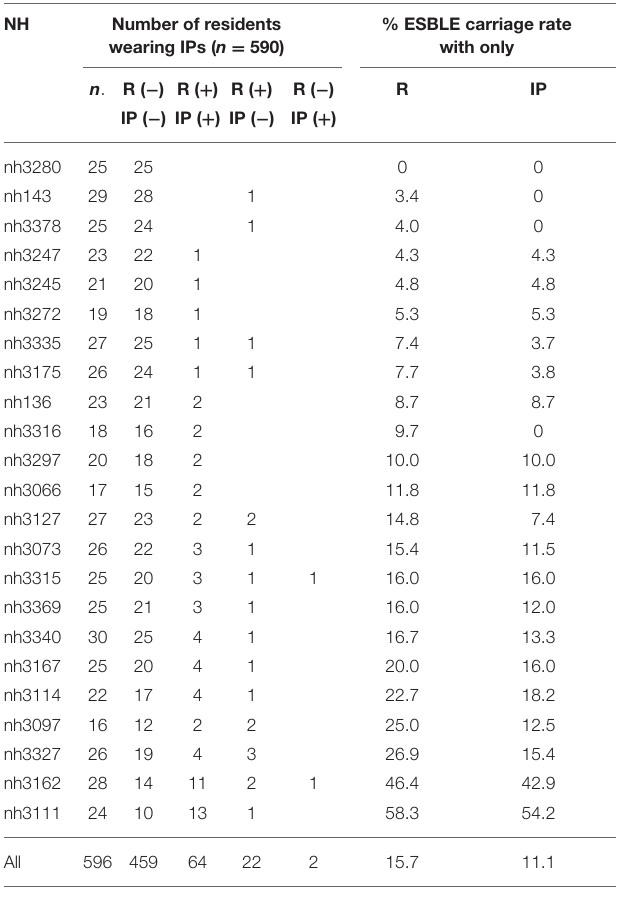
TABLE 3 | Comparison of the ESBLE carriage detection rates obtained with rectal (R) and incontinence product (IP) swabs. NH Number of residents wearing IPs ( n =